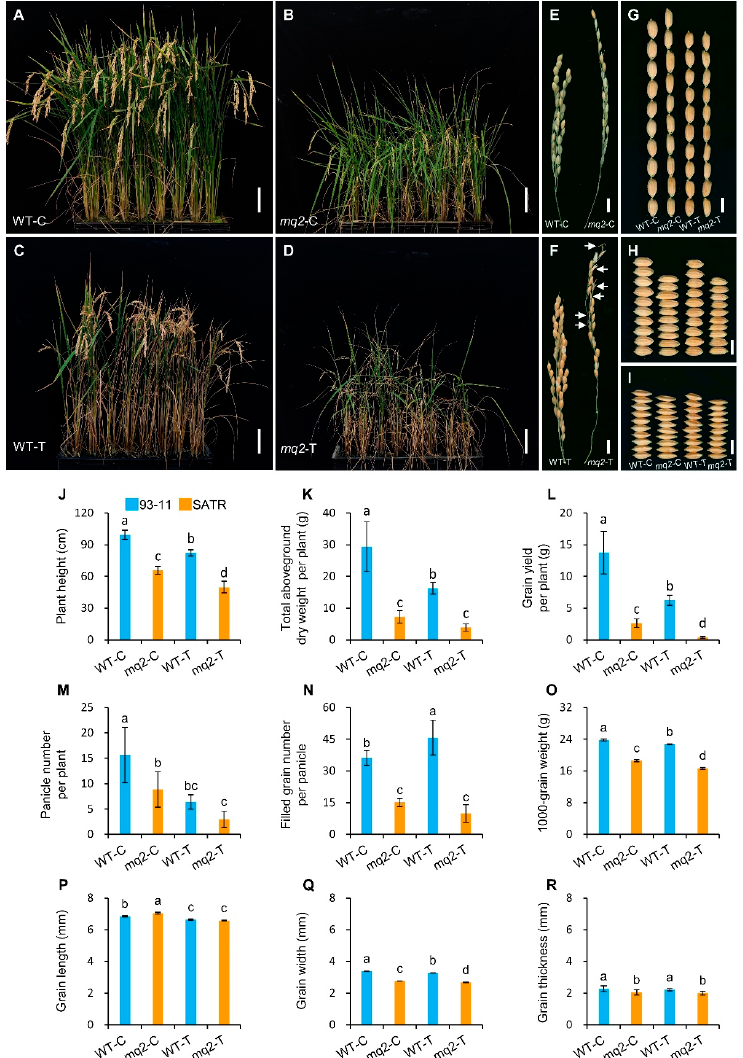
Figure 8. Effects of OsCSLD4 on the biomass and grain yield under NaHCO 3 treatment. ( A , B ) Mor- phologies of wild-type Kitaake (WT-C) ( A ) and mq2 mutant ( mq2 -C) plants ( B ) at maturation stage which were grown in a same cultivating box under controlled growth conditions without NaHCO 3 treatment. ( C , D ) Morphologies of wild-type (WT-T) ( C ) and mq2 ( mq2 -T) ( D ) plants at maturation stage which were grown in a same cultivating box and treated with approximately 8‰ NaHCO 3 in the soil. ( E , F ) Panicle morphologies of WT-C and mq2 -C plants ( E ) as well as WT-T and mq2 -T plants ( F ). ( G – I ) Grain length ( G ), grain width ( H ) and grain thickness ( I ) phenotypes of WT-C, mq2 -C, WT-T and mq2 -T plants. ( J – R ) Statistics of plant height ( J ), total aboveground dry weight per plant ( K ), grain yield per plant ( L ), panicle number per plant ( M ), filled grain number per panicle ( N ), 1000-grain weight ( O ), grain length ( P ), grain width ( Q ) and grain thickness ( R ) of WT-C, mq2 -C, WT-T and mq2 -T plants. WT, the wild-type plants (Kitaake) harboring the functional OsCSLD4 gene; mq2 , the OsCSLD4 function-disrupted mutant of Kitaake. The blue and orange bars indicate wild-type and mq2 mutant, respectively ( J – R ). Bar = 10 cm ( A – D ), 10 mm ( E , F ) and 5 mm ( G – I ), respectively. Data is given as mean ± SD, which was obtained from eight independent biological replicates ( J – N ) or three independent biological replicates ( O – R ). Each independent replicate contained one plant ( J – N ), or ≥ 200 grains ( O – Q ), or 40 grains ( R ). The different letter on the bar in each bar chart ( J – R ) indicates the significant difference at p < 0.05 level obtained by ANOVA with Duncan’s new multiple range